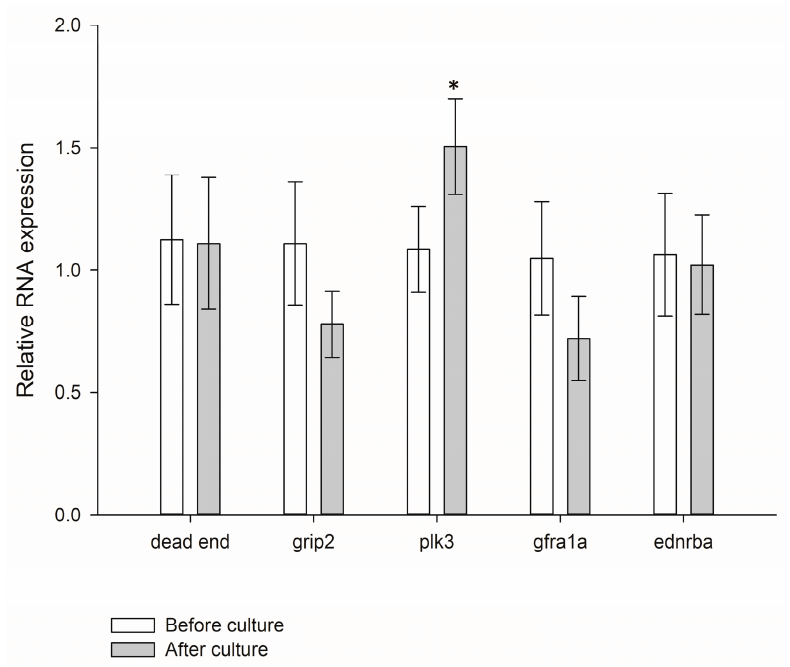
Figure 7. Expression of dead end , grip2 plk3, gfra1a , and ednrba in germ cells before and after 10-d culture. Data are shown as mean ± SEM ( n = 3). Differences were considered significant at p < 0.05. The asterisk indicates significant difference of gene expression compared to before culture according to paired t -test.